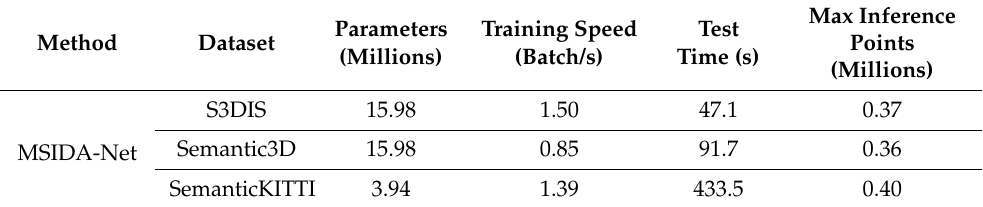
Table 7. Information of the proposed model on different